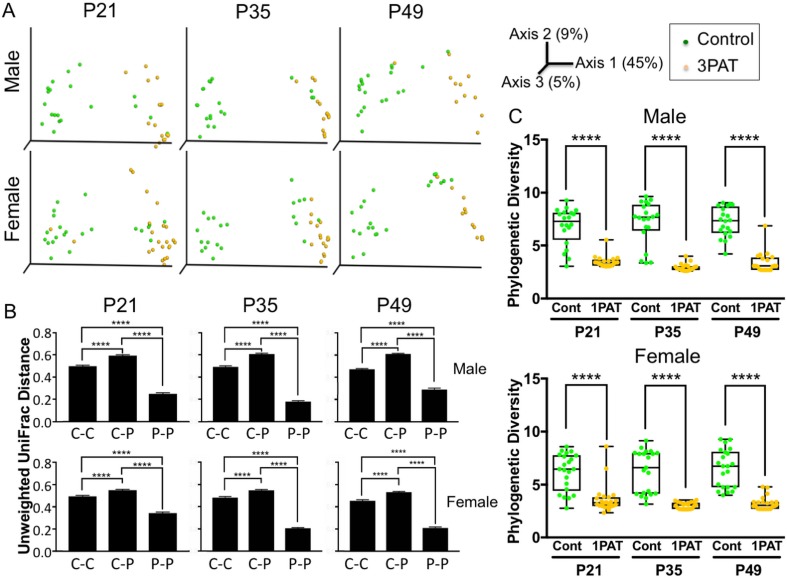
Microbiota characteristics of 3PAT and control NOD mice in early life.(A) β-diversity, as measured by unweighted UniFrac analysis of fecal microbiota over time (P21, P35, and P49). (B) Inter- and intra-group UniFrac distances. Significance determined by one-way-ANOVA with Tukey method for correction for multiple comparisons. ****p<0.001. C-C, C-P and P-P represent the intra-group distances within controls, inter-group distances between controls and PAT, and intra-group distances within PAT, respectively. (C) α-diversity (Phylogenic diversity (PD)) of fecal microbiota. Statistical significance determined by one-way-ANOVA. ****p<0.0001.